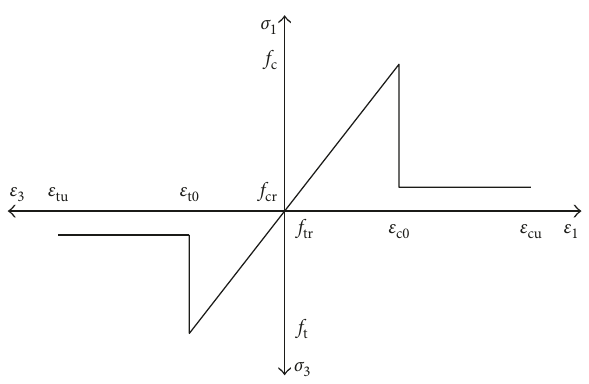
Figure 5: Elastic-brittle damage constitutive law of mesoscopic elements subjected to uniaxial compressive and tensile